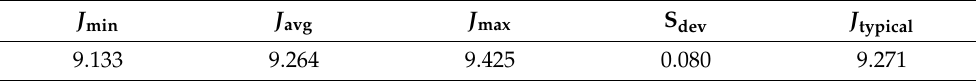
Table 9. Statistics regarding the optimum criterion ( SENSOR mode = 1).